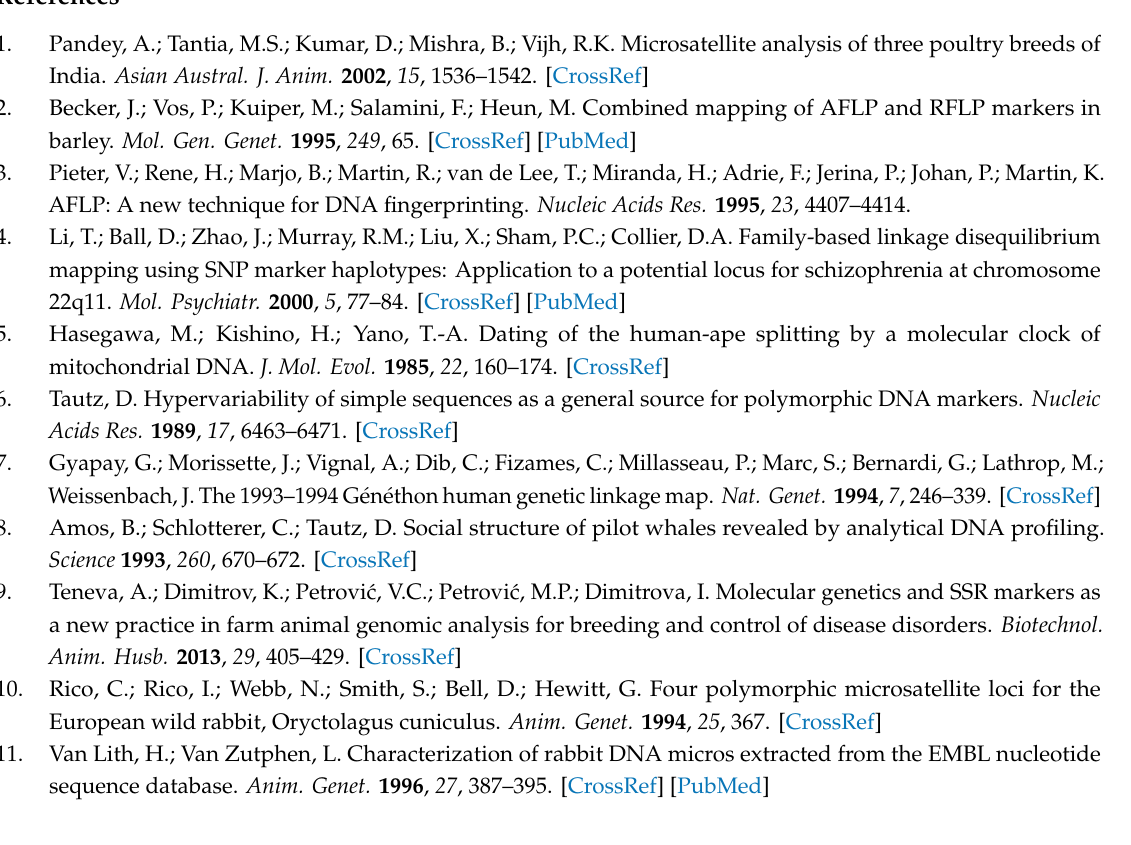
Tables S1 and S2: Combination of fluorescent SSR primers and reaction conditions, Table S3: A list of selected loci, Table S4: No. 1 to 15 SSR marker combination information, Table S5: No. 16 to 30 SSR marker combination information, Figure S1: Detection of SOL03 production by 1% agarose gel electrophoresis. The marker is 5000 bp.The SOL03 production is 250 bp, Figure S2: ABI-3730XL analyzer detection of SOL44, 6L2H3, and SOL30 loci. All allele sizes of the SSR are within 500 bp, Figure S3: Comparison of genetic diversity analyses of two New Zealand rabbit generations using the two SSR marker combinations. There were no significant di ff erences among the mean values of each genetic diversity parameter using the 22 optimal loci and the 43 original loci for the F0 and F1 generations of New Zealand white rabbits ( p >